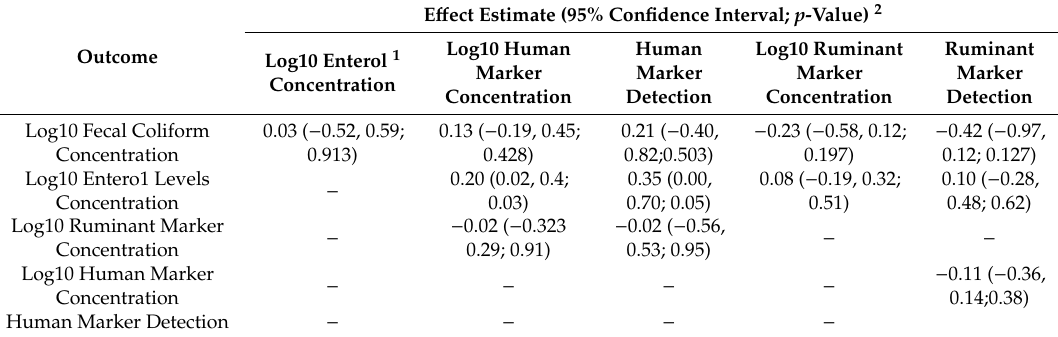
Table 4. Association between microbial water quality parameters, including fecal indicator bacterial concentrations and MST marker concentrations, in Onondaga